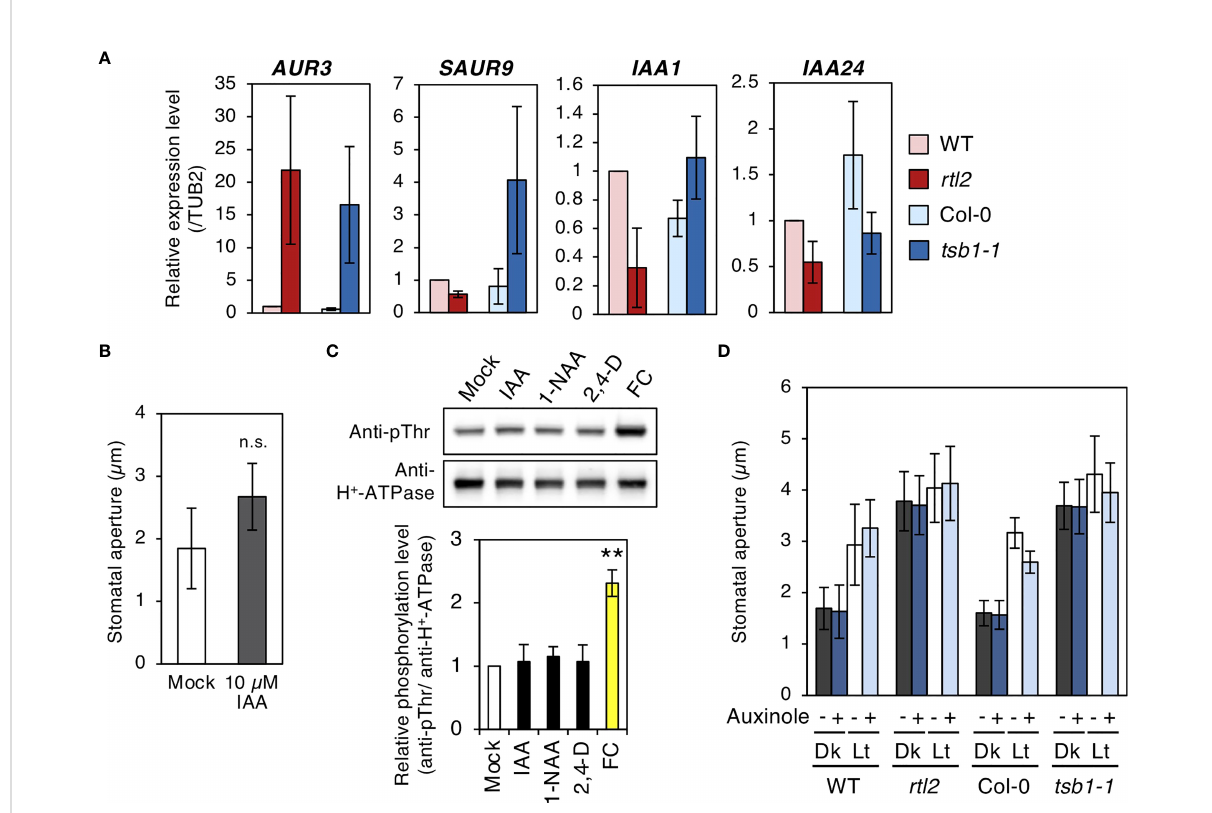
FIGURE 6 Characterizations of rtl2 and tsb1-1 mutants and auxin responses in stomata. (A) Expression of auxin responsive genes analyzed by qRT-PCR in WT, rtl2 , Col-0 and tsb1-1 . Total RNA was extracted from rosette leaves of 5-week-old plants grown on MS plate for 4 weeks and transferred to soil for 1 week. TUB2 was ampli fi ed as a control. (B) Effect of exogenous auxin on stomatal aperture in Col-0. Epidermal tissues from dark- adapted 4-week-old plants grown on soil were incubated with 0.25% (v/v) DMSO (Mock) and10 µM IAA in the dark for 3 hr. Values represent mean ± SD (n = 4); measurement of 45 stomata in each experiment n.s. not signi fi cant. (C) Effect of auxins to the phosphorylation status of the penultimate residue, Thr, of PM H + -ATPase in guard cell protoplasts (GCPs) from Vicia faba . GCPs were incubated with IAA and synthetic auxins (1-NAA, 2,4-D) and fusicoccin (FC) at 10 µM in the dark for 30 min. DMSO was used as a solvent control (Mock). Immunoblots of the phosphorylated PM H + -ATPase and total PM H + -ATPase were performed using anti-pThr antibody and anti-H + -ATPase antibody,